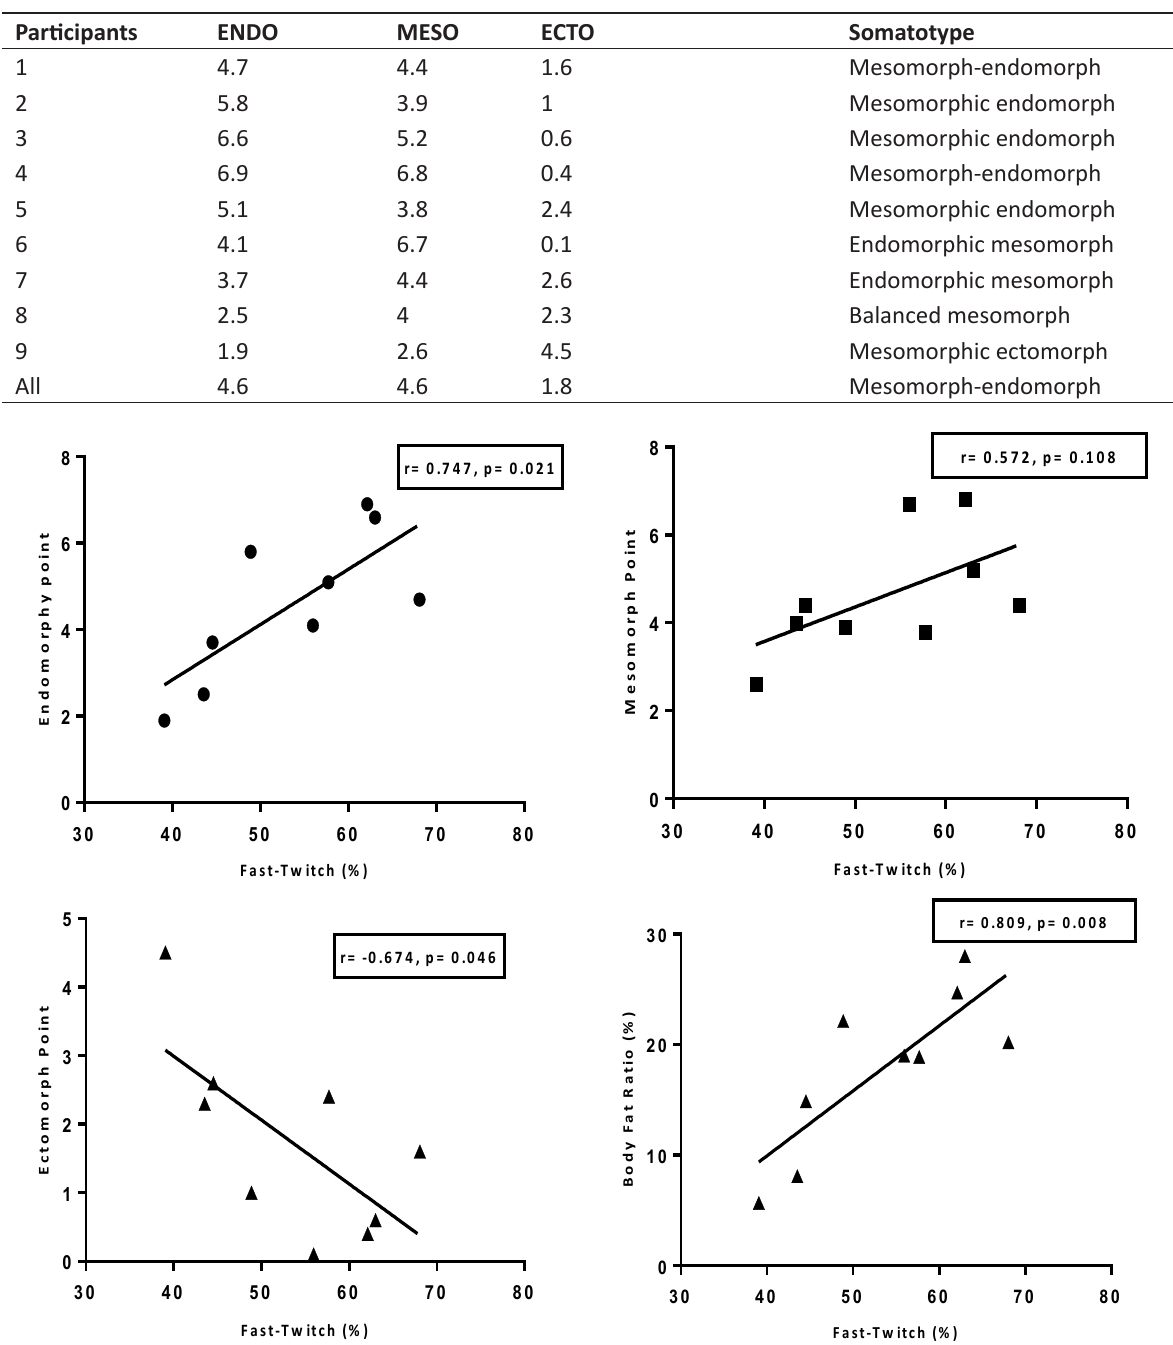
Table 2. The somatotype scores of each participant in the study Participants